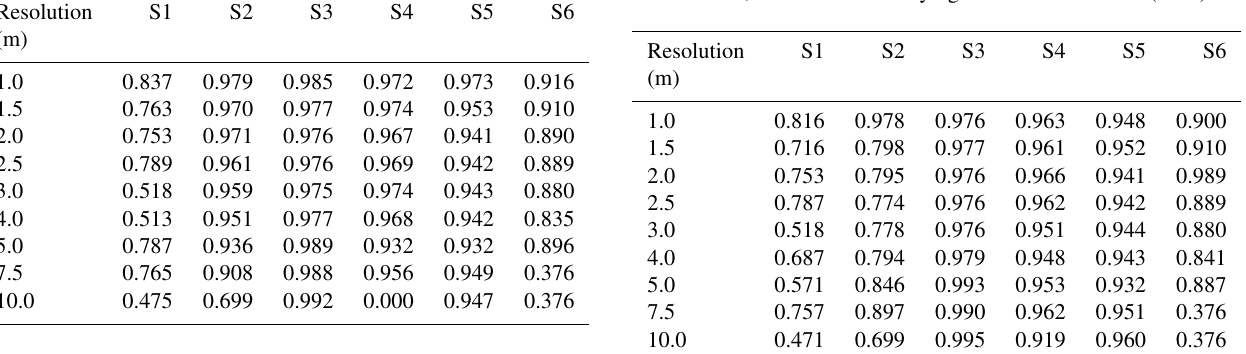
Table A5. Table of precision for sites S1 to S6 (columns) with a Wiener filter, for resolutions varying between 1 and 10m (rows).